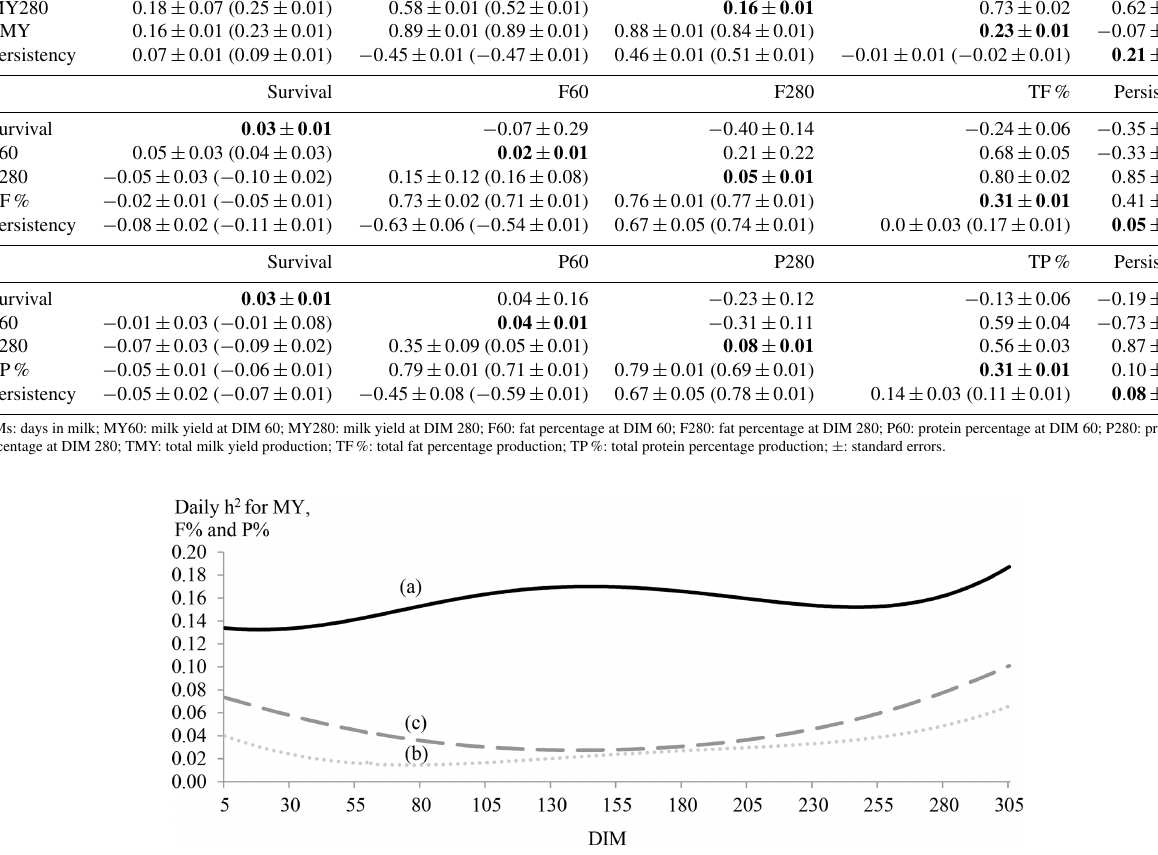
Figure 2. Daily estimates of heritability ( h 2 ) for MY (continuous line; a ), F% (dotted line; b ) and P% (dashed line; c ) by days in milk